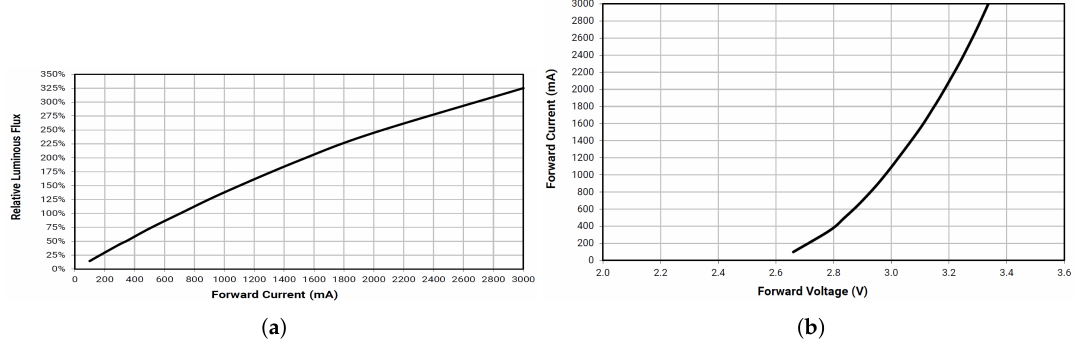
Figure 2. Operating point of a Cree XM-L white LED [15]. Used with permission of Cree, Inc. ( a ) almost linear relationship between LED current and luminous flux; ( b ) current–voltage characteristic. Note the non-zero starting x -axis.